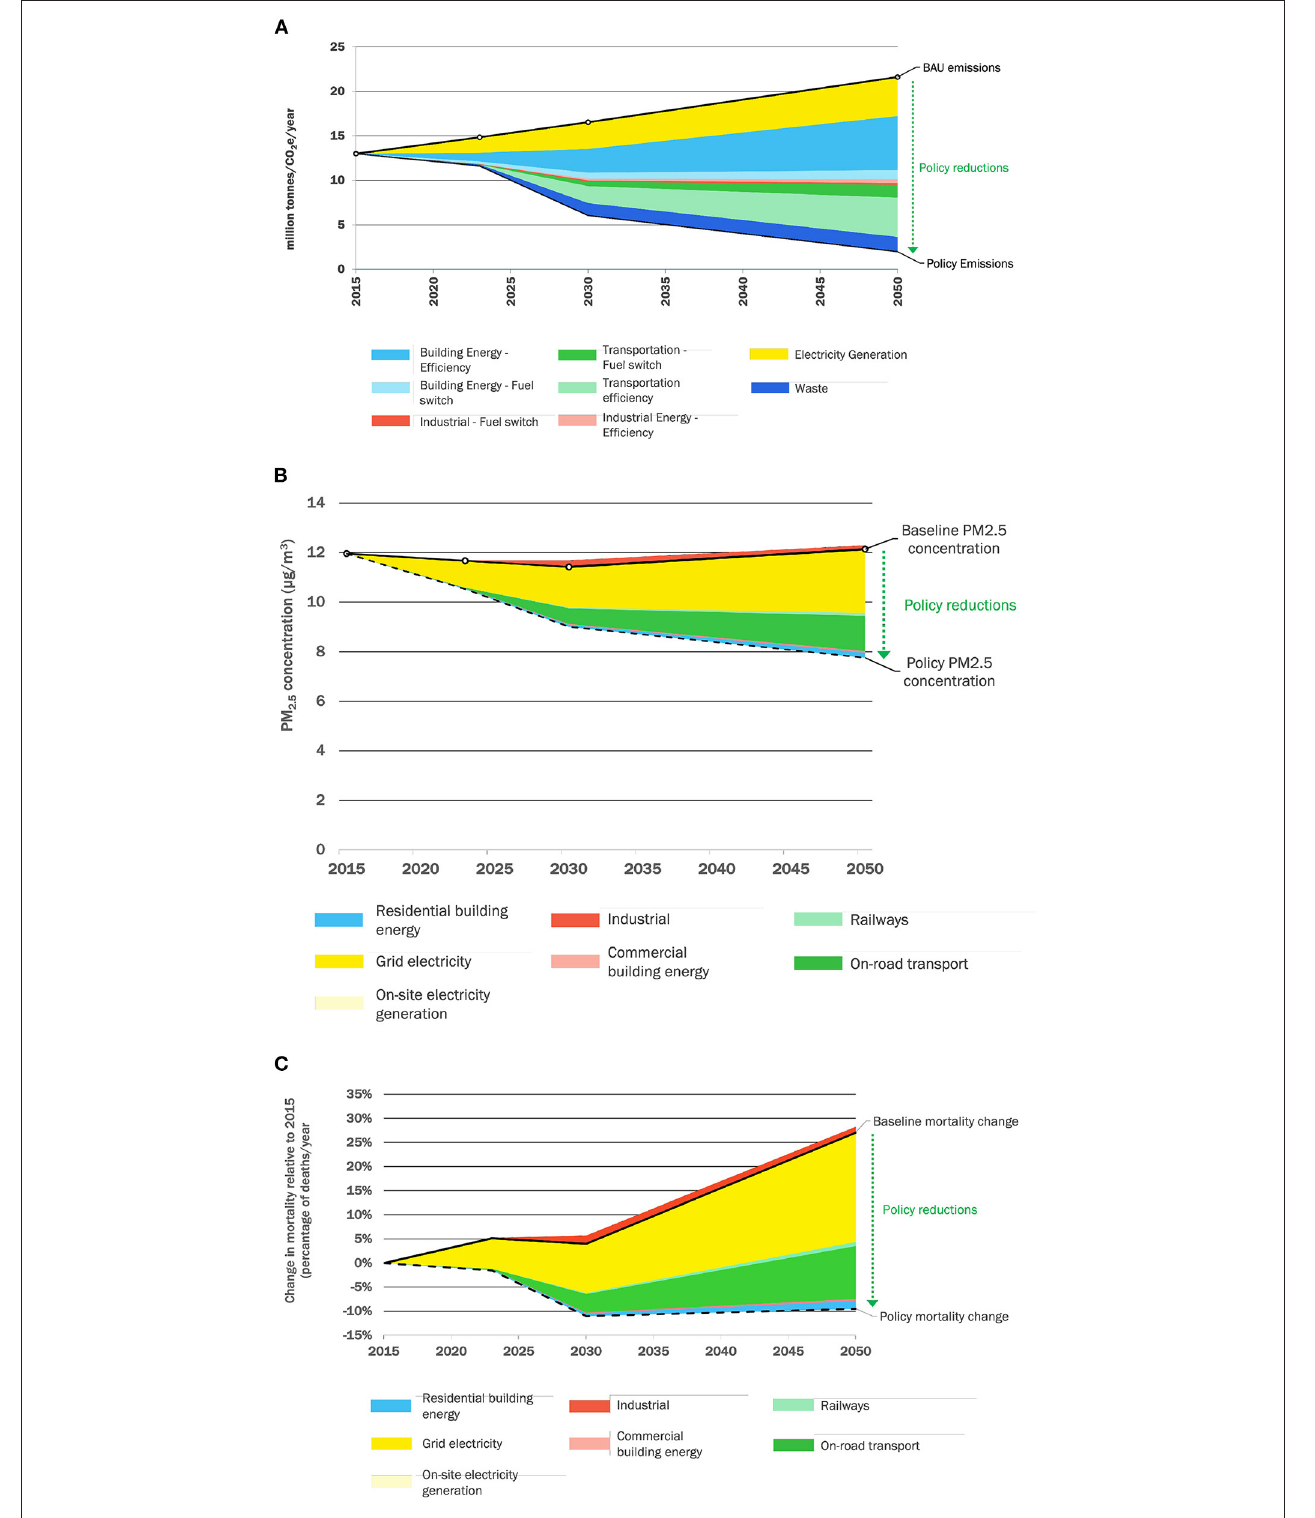
FIGURE 4 | Estimated impacts for Buenos Aires under an “Ambitious” GHG reduction strategy, including (A) projected annual GHG emissions, (B) estimated change in annual average PM 2.5 , and (C) estimated percent change in PM 2.5 -attributable premature deaths per year. Mortality estimates for the city of Buenos Aires are based on local data provided by the Statistical Agency of the city of Buenos Aires.